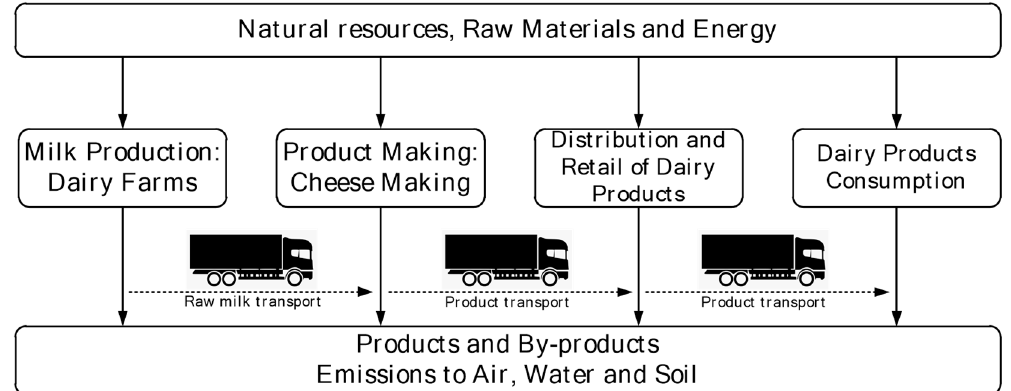
Figure 2. System boundaries.